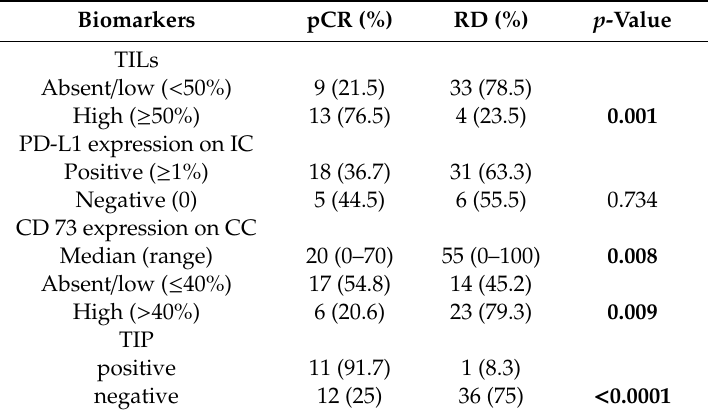
Table 4. Expression of single biomarkers, tissue immune profile, and response to NACT.